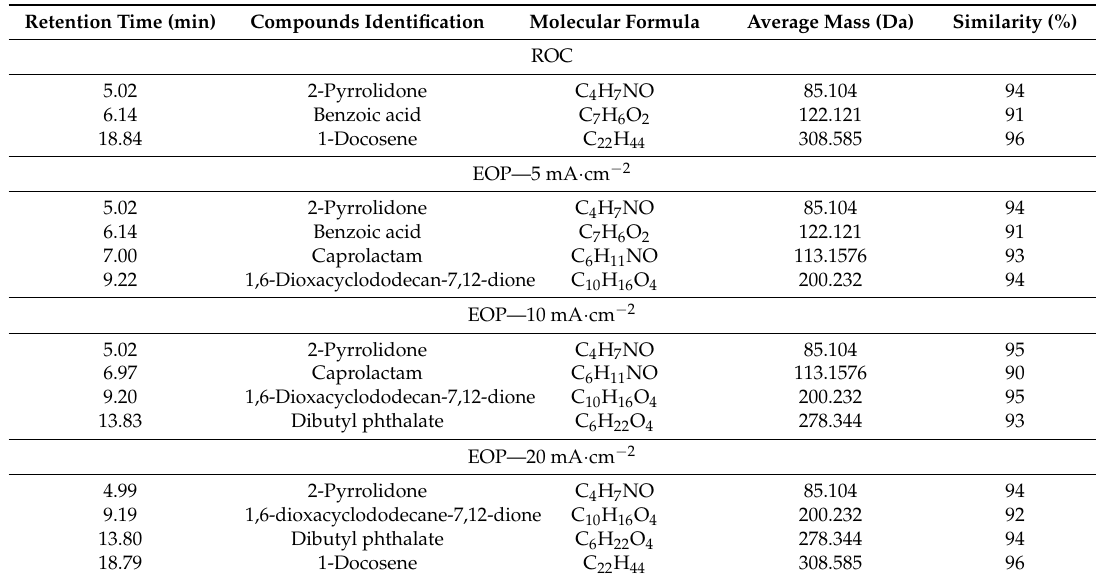
Table 2. Compounds identified by tentative comparison with the NISTMS-2008 library with more than 90% of probability in ROC and EOP applying 5, 10, or 20 mA · cm − 2